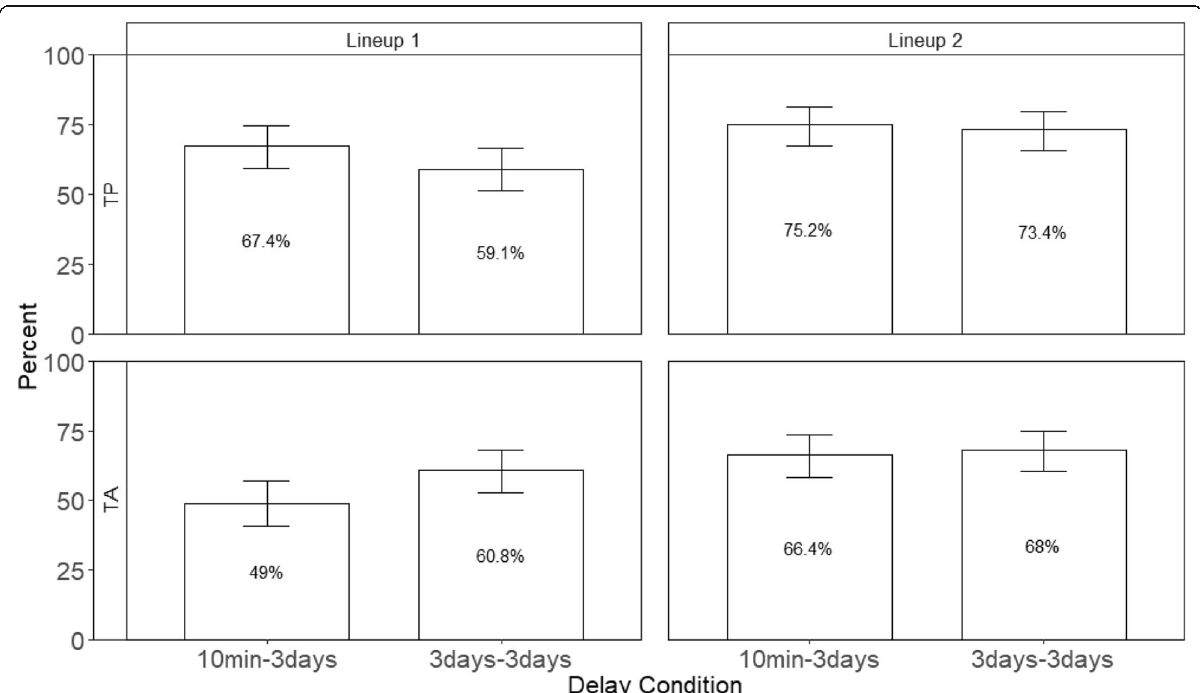
Fig. 2 The percentage of choosers across lineups and delay conditions in Experiment 1. The top panels show the target-present lineups and the bottom panels show the target-absent lineups. Error bars represent 95% confidence intervals